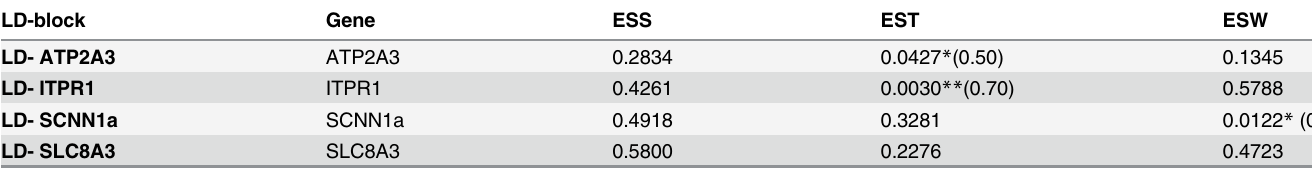
Table 5. Association analysis of the diplotypes with eggshell mechanical property traits a,b,c .